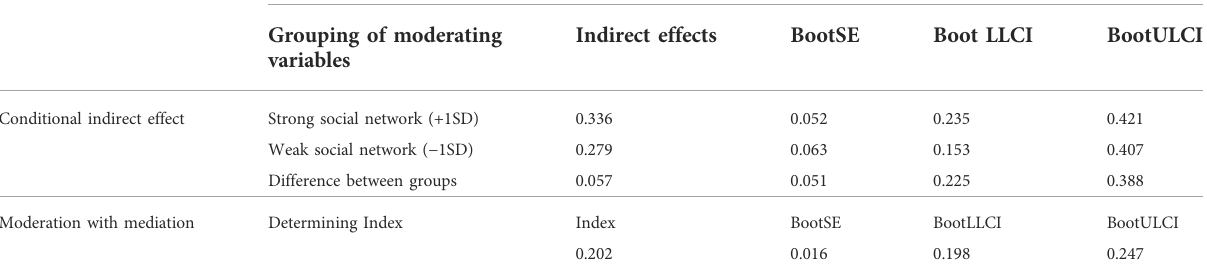
TABLE 5 Analysis of moderating effect with